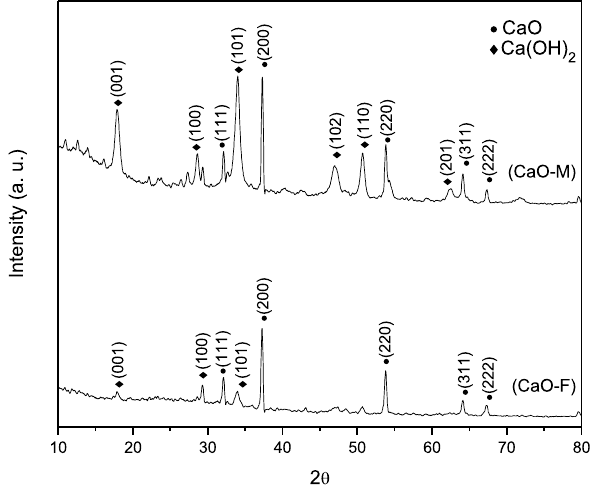
Fig. 2 X-ray diffraction patterns of CaO-M and CaO-F samples